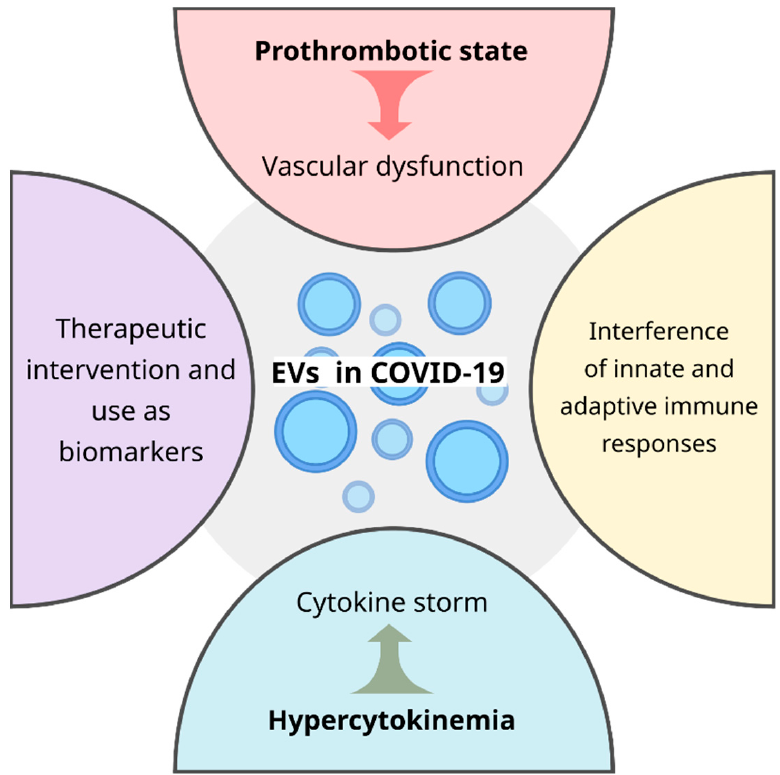
Figure 2. During COVID-19 disease, EVs are key players in the vascular dysfunction, cytokine storm, innate and adaptive immune responses and may have a potential application as therapeutic intervention and as a non-invasive biomarker, improving the clinical outcome of patients.